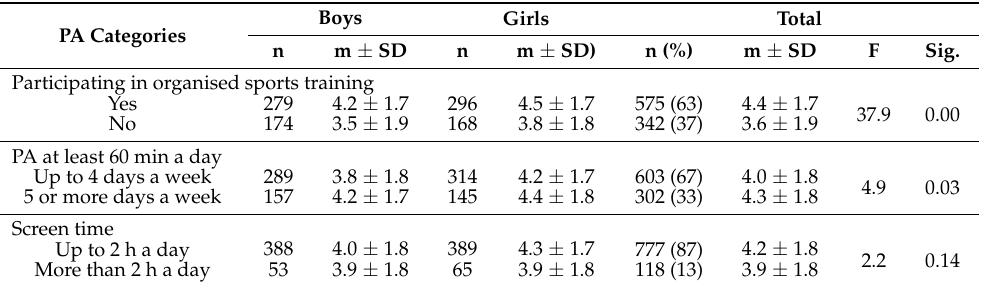
Table 4. Mean knowledge score ( ± SD) according to physical activity (PA) classification categories for boys and girls. Statistical significance was calculated by using analysis of